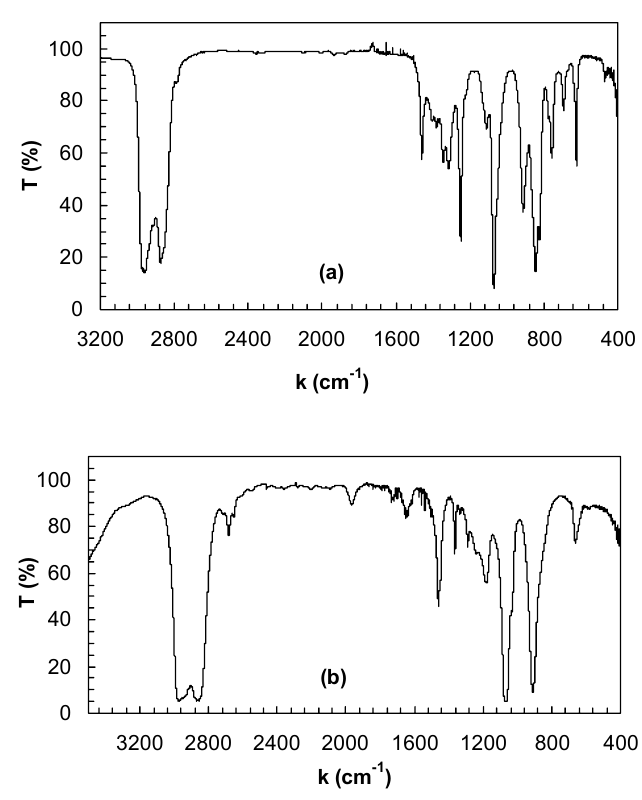
Fig. 3 IR spectra of: (a) bis(trimethylsilyl) selenium in THF (110 μ m inner space thick- ness of the KBr cell); (b) tetrahydrofuran (THF) (20 μ m inner space thickness of the KBr